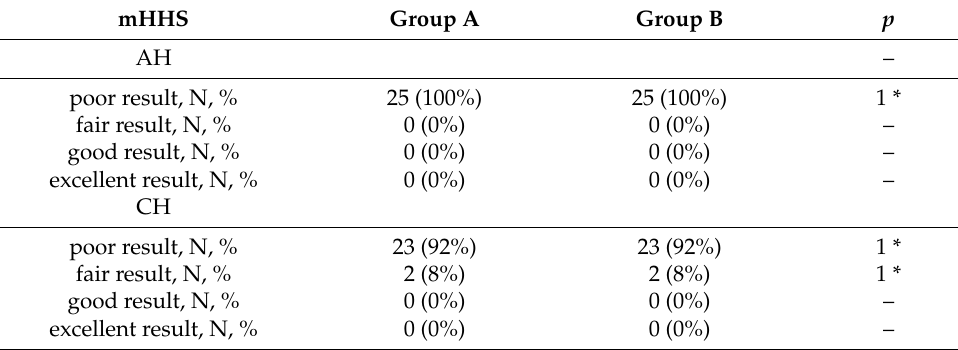
Table 4. The initial values of mHHS in the two